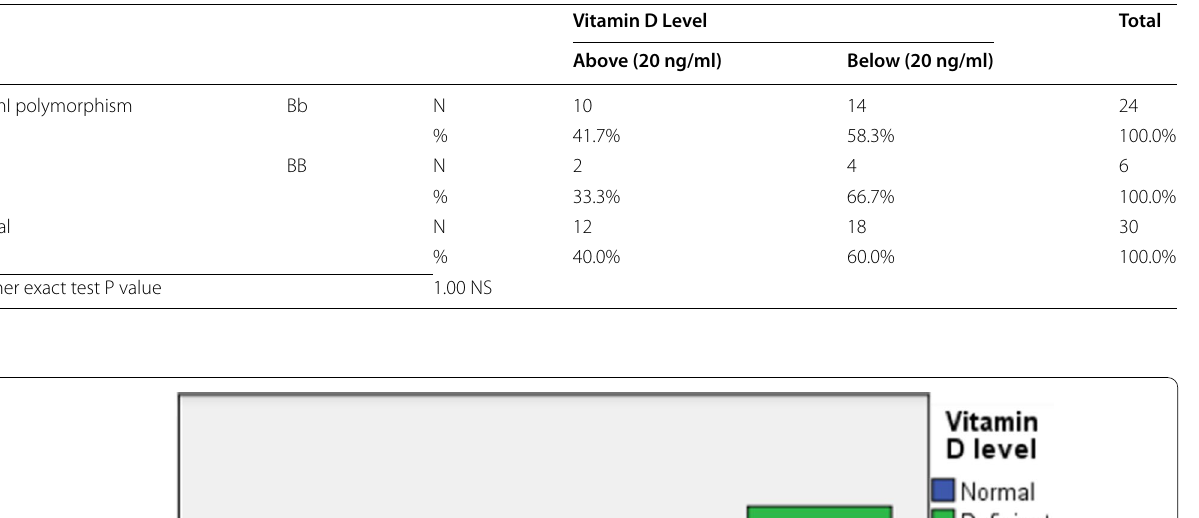
Table 4 BsmI gene polymorphism among male obese students with deficient and nondeficient vitamin D levels